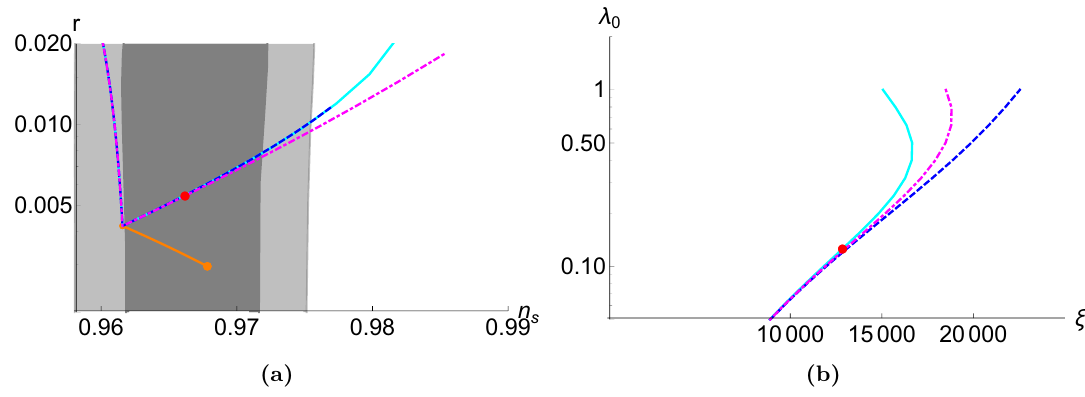
Figure 2 . Metric formulation: zoom of r vs. n s (a) for r ≤ 0 . 02 and λ vs. ξ (b) for λ 0 ≥ 0 . 05 . The color code is the same as in figure